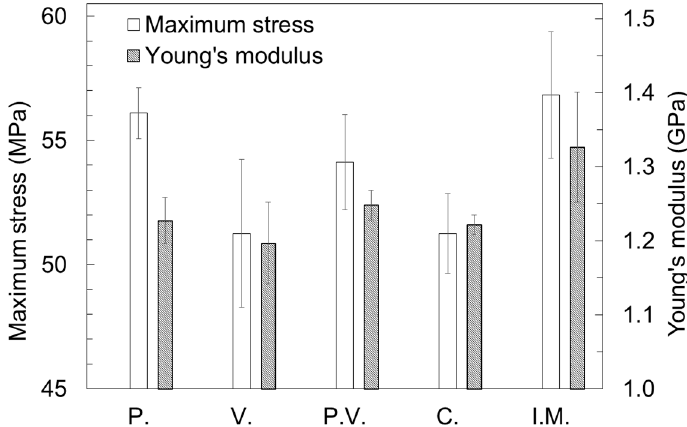
Figure 6. Maximum tensile stresses and Young’s moduli of non-immersed test pieces. Average ± S.D., n = 5.